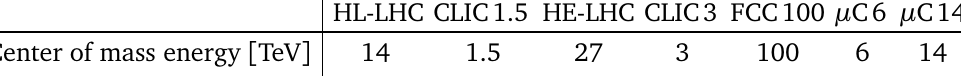
Table 1: Collider parameters used in our off-shell Higgs